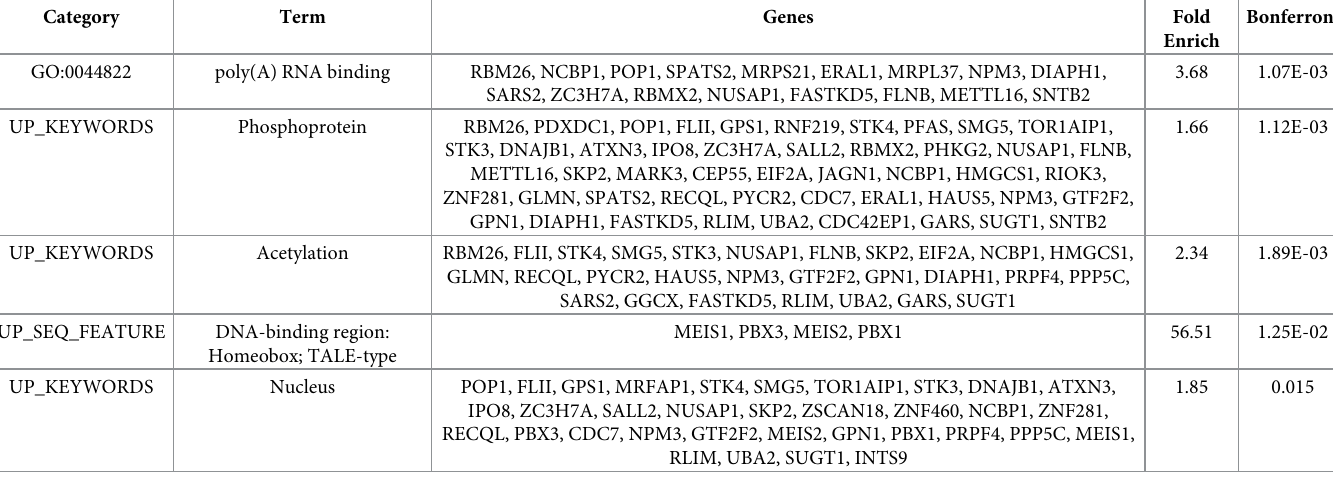
Table 2. Significantly enriched terms relating to MAB21L1-interacting proteins using DAVID Functional Annotation Chart.